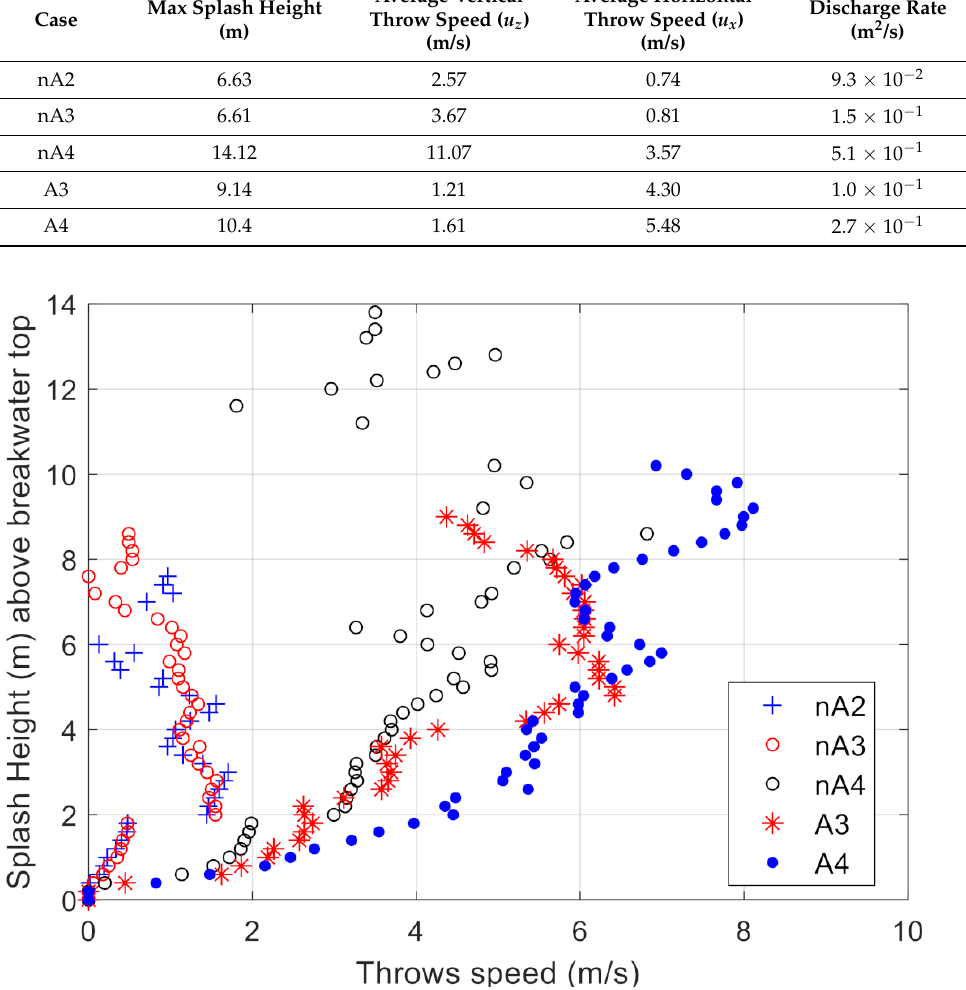
Figure 12. Profile of the average horizontal throw speed above the